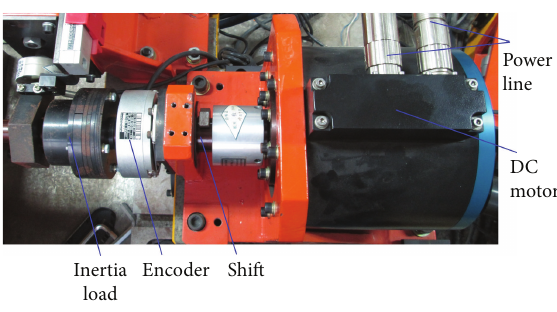
Figure 2: Experimental platform of DC motor driven